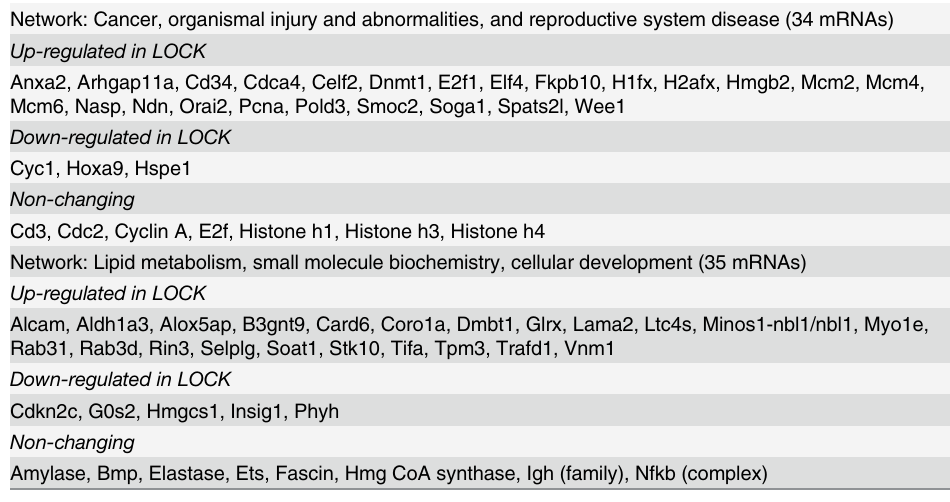
Table 6. List of transcripts from top scoring IPA networks inclusive of both up-regulated and down- regulated genes as influenced by wheel locking (LOCK) (score = 41 for both networks). Network: Cancer, organismal injury and abnormalities, and reproductive system disease (34